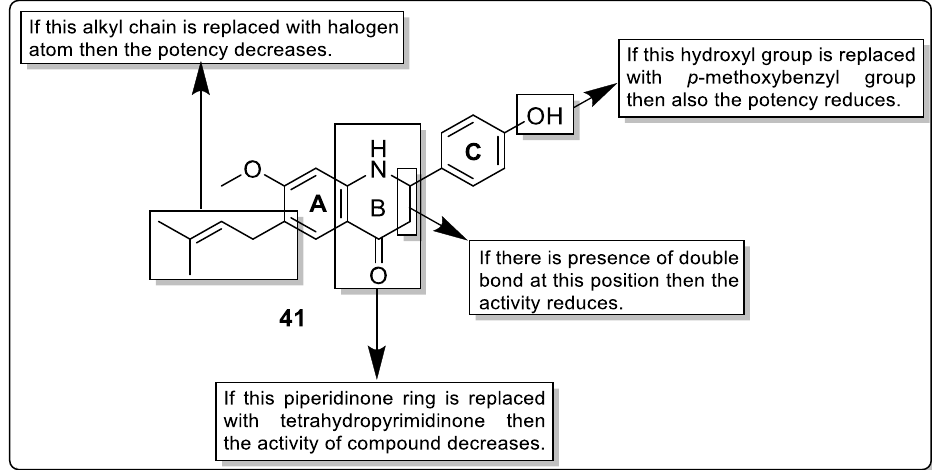
Figure 45. Structural activity relationship of bavachinin hybrids ( 41 ) as potent PPAR ligands.